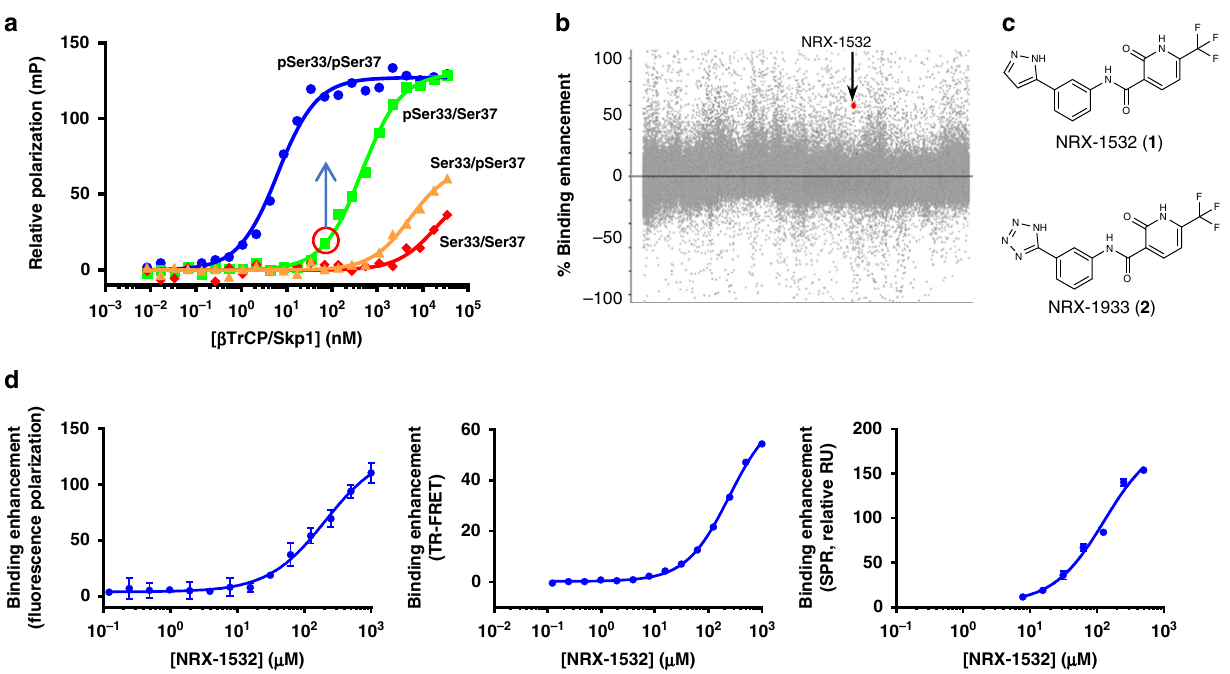
Fig. 1 Identi fi cation of small molecule enhancers of β -catenin: β -TrCP interaction. a β -TrCP complex was titrated against 5 nM BODIPY-TMR-labeled β - catenin peptide (residues 17 – 48) of various phosphorylation status and binding was monitored by fl uorescence polarization. Binding af fi nities were estimated by curve fi tting to a one-site binding model. Circled on the pSer33/Ser37 β -catenin binding curve is the β -TrCP concentration that results in 20% binding saturation, which was used in the HTS. b Binding enhancement for all compounds screened in the HTS using the FP assay. Each dot represents an individual compound, with NRX-1532 highlighted. c Chemical structure of the enhancers, NRX-1532 and NRX-1933. d Enhancement of pSer33/Ser37 β - catenin peptide binding to β -TrCP with increasing concentrations of NRX-1532. In each assay, the concentration of either β -TrCP or β -catenin was adjusted to obtain 20% binding saturation in the absence of compound. Shown is a representative experiment, values reported are